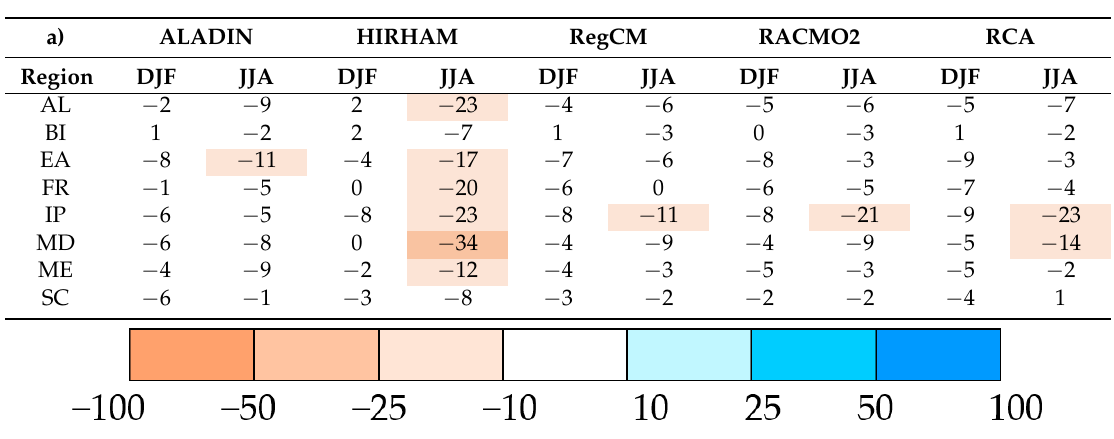
DJF but increased it in summer (JJA) in ALADIN, HIRHAM and RegCM in some regions (Table 3b). Table 3. Residual bias of seasonal amount of simulated precipitation (a) and of seasonal mean of simulated temperature (b) in the case of eQM bias correction in eight different regions: the Alps (AL), the British Isles (BI), Eastern Europe (EA), France (FR), the Iberia Peninsula (IP), the Mediterranean (MD), Mid-Europe (ME) and Scandinavia (SC) in DJF and JJA The bias values are in % and in °C in the case of precipitation and temperature, respectively.